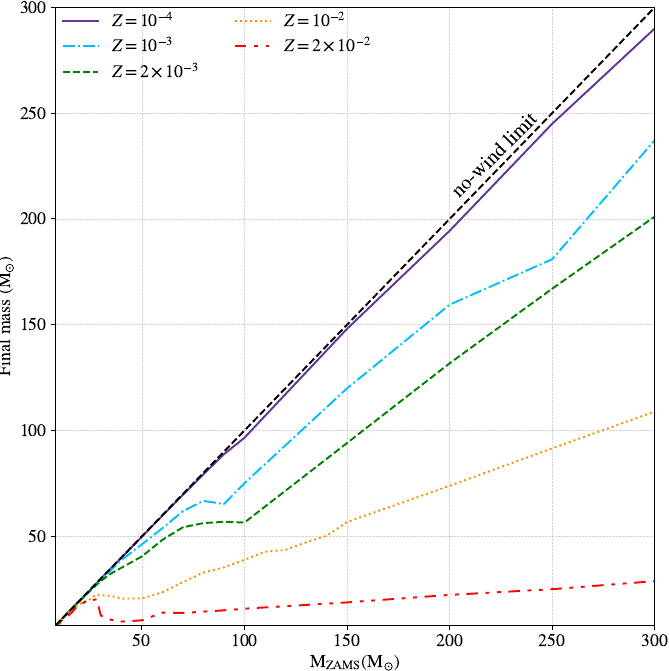
Figure 2. Final mass of the stars as a function of their initial mass, for different values of metallicity. The dashed line at 45 degrees corresponds to the no-wind limit (i.e., final mass = initial mass). Plot obtained with the SEVN population-synthesis code [97] with look-up tables for single-star evolution from the PARSEC code